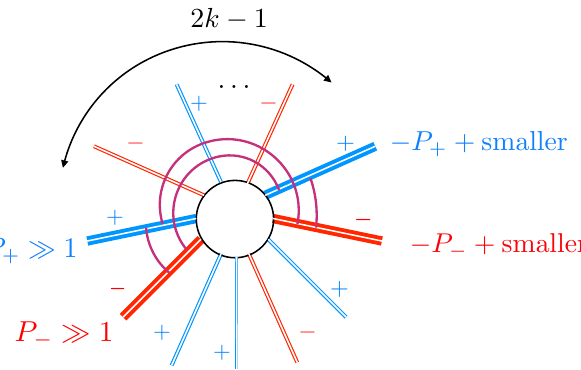
Figure 4 . If four momenta are much larger than the other ones then the contact amplitude is simply given by the four terms in the vertex which couple pairs of such large momenta with opposite chirality. No particle production thus sets those simple combinations to vanish. Carefully choosing which momenta are large immediately lead to g n; 2 k +1 = g n; 1 as illustrated